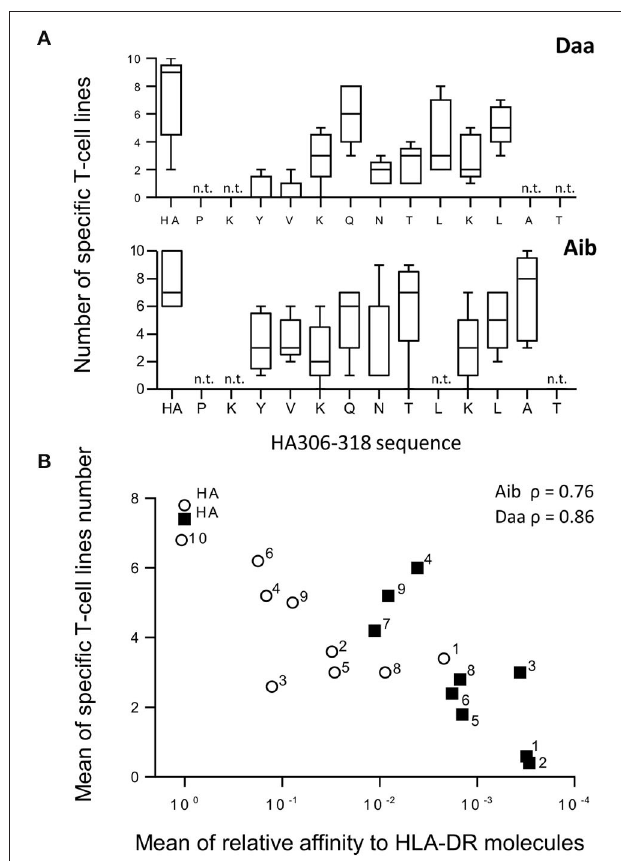
FIGURE 5 | Generation of CD4 T-cell lines specific for Aib and Daa analogs. (A) CD4 T-cell lines were produced by 3 weekly rounds of stimulation with autologous mature DCs previously loaded with either HA or each analog using cells collected from 5 different donors. Specific T-cell lines were identified by IFN- γ ELISPOT from 10 independent cell cultures per peptide, each analog being identified by the modified position in the HA sequence (x axis). Boxes extend from the 25th − 75th percentiles, the line in the middle of the box is plotted at the median and the whiskers go down to the smallest value and up to the largest. n.t., not tested. (B) Mean number of T-cell lines specific for Aib (open circle) and Daa analogs (closed square) was plotted as a function of their HLA-DR binding (ratio of IC 50 of analog to that of HA). Numbers refer to the position relative to the P1 anchor residue of HA. ρ refers to Spearman’s rank correlation